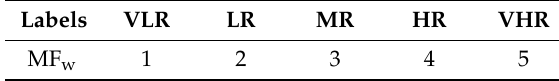
Table 1. Membership labels along with assigned